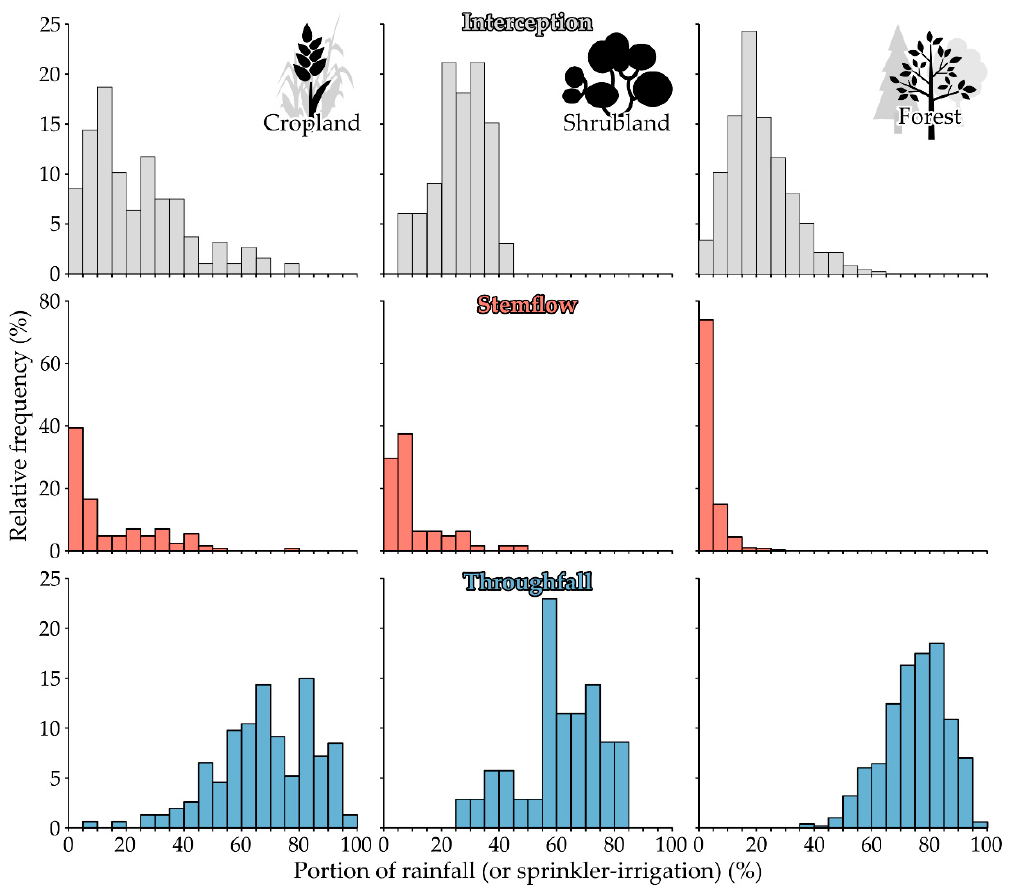
Figure 5. Relative frequency histograms of observed relative interception, stemflow, and throughfall for all crops, shrubs, and forests show rainfall partitioning patterns across vegetation types. Shrub and forest data from a recent synthesis of these data [9].